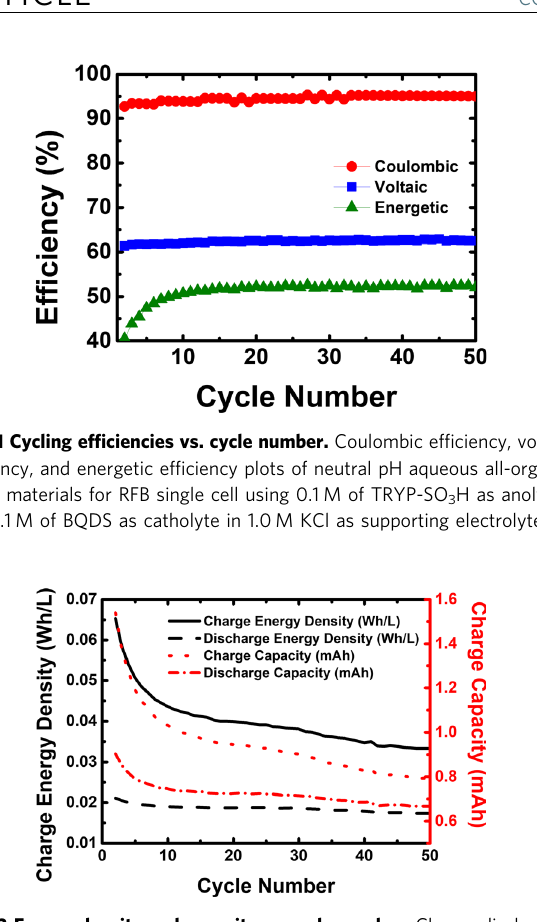
Fig. 12 Energy density and capacity vs cycle number. Charge-discharge energy density and charge – discharge capacity plots of neutral pH aqueous all-organic active materials for RFB single cell using 0.1 M of TRYP-SO 3 H and 0.1 M of BQDS as catholyte in 1.0 M KCl as supporting